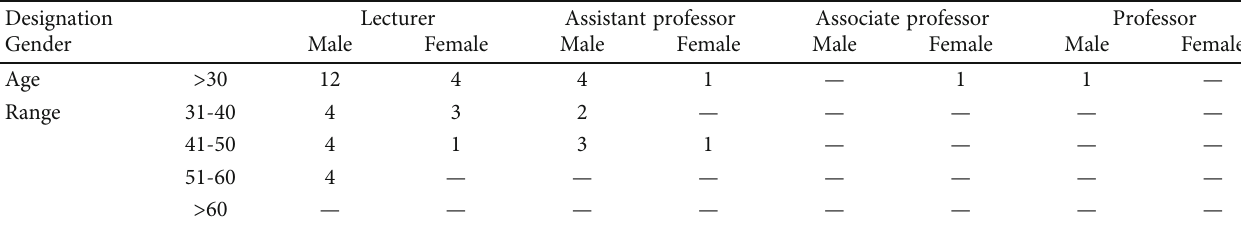
Table 1: Age and gender of lecturer ’ s responses are shown.